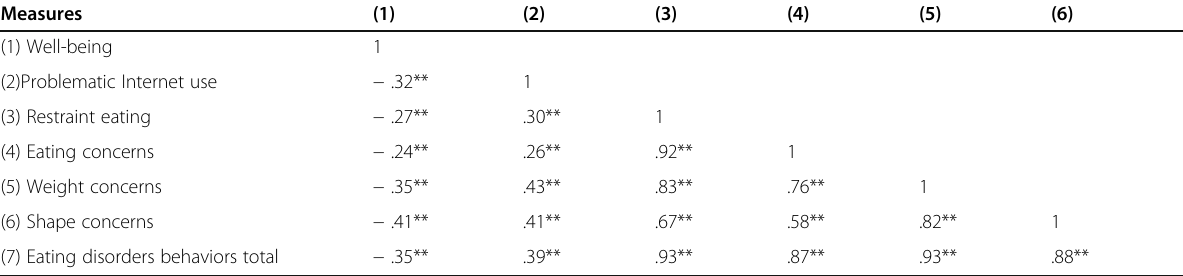
Table 2 Correlations among study variables ( N = 566)